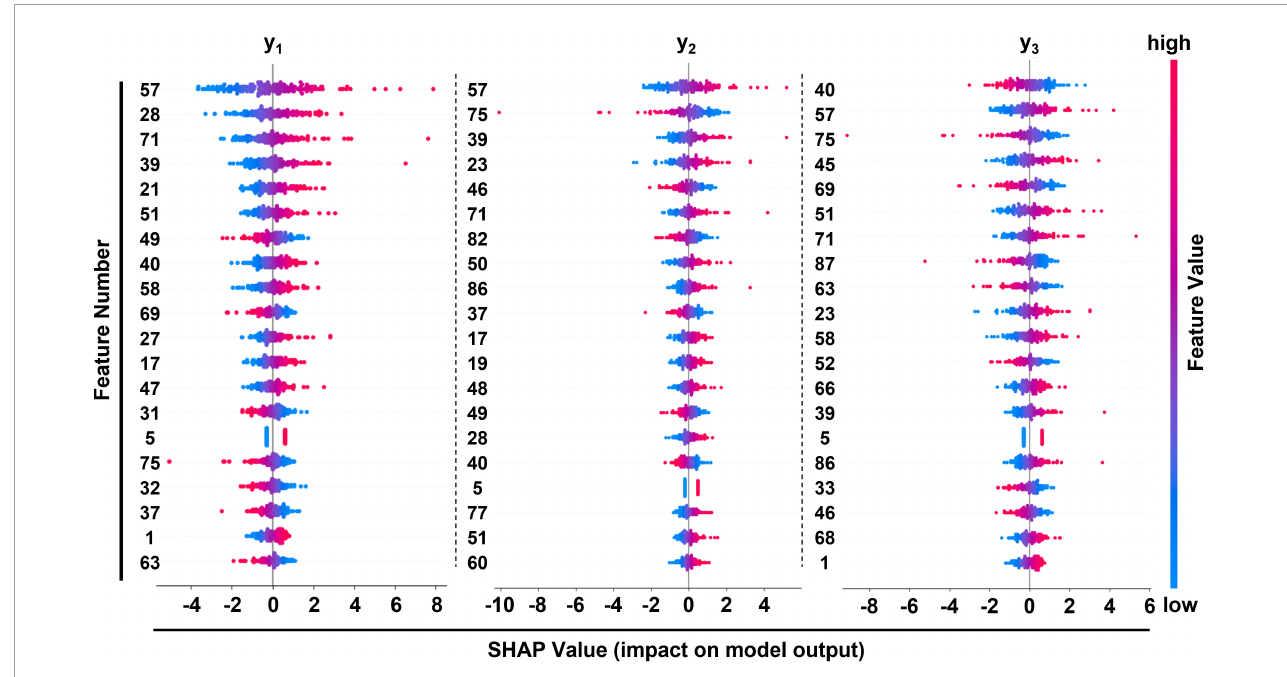
FIGURE4 Summary plot of feature importance in SVM model at 3 different positions of prediction. Corresponding features of feature numbers were listed in Supplementary Table 1 .